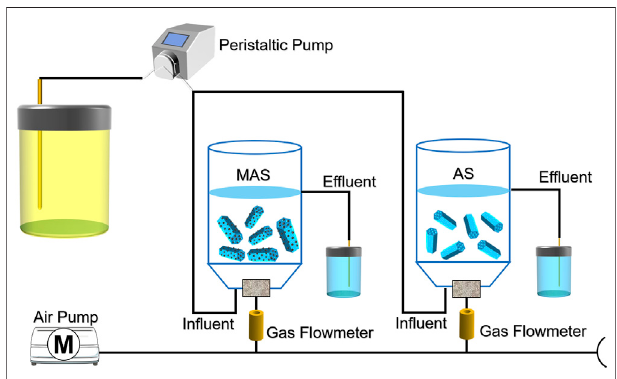
FIGURE 1 | Diagram of the experimental